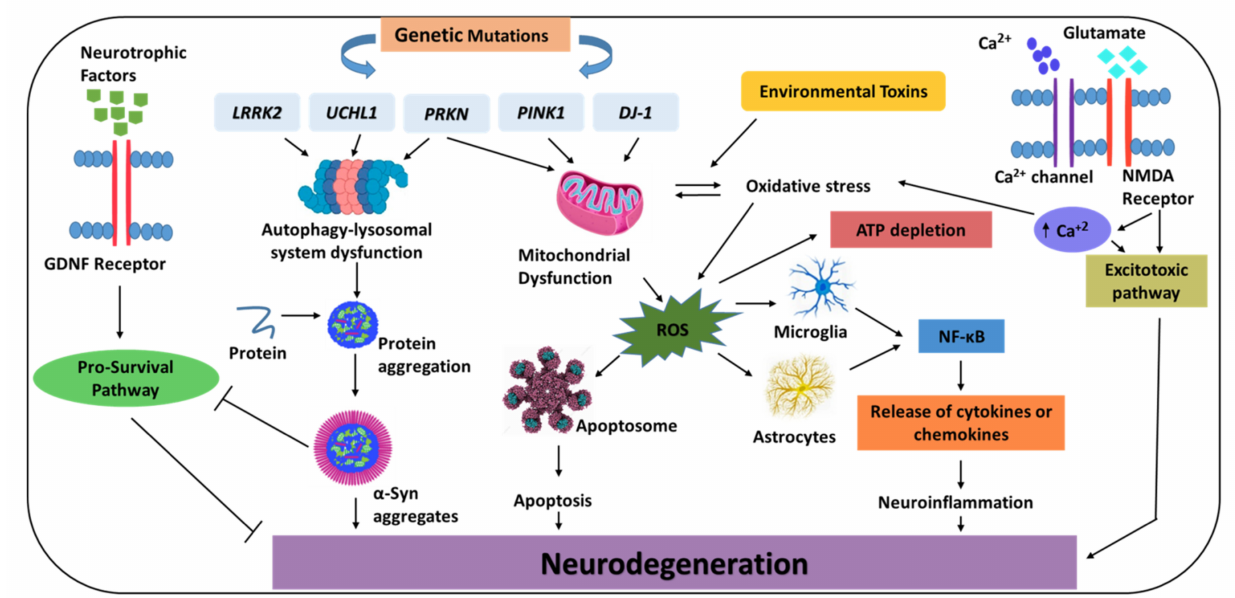
Figure 1. Molecular pathways involved in the pathophysiology of Parkinson’s disease (PD). Common pathogenic mechanisms in PD, including genetic mutation, defective protein clearance, mitochondrial dysfunction, loss of trophic factors, alterations of intracellular Ca 2+ homeostasis, and neuroinflamma- tion, are illustrated. Enhanced signaling pathways are indicated by solid arrows, and suppressed pathways are by blocked arrows. GDNF: glial cell-derived neurotrophic factor, LRRK2 : leucine-rich repeat kinase 2, UCHL1 : ubiquitin C-terminal hydrolase L1, PRKN : parkin, PINK1 : phosphatase and tensin homolog-induced kinase 1, DJ-1 : Daisuke-Junko-1, α -Syn: alpha-synuclein, ROS: reactive oxy- gen species, TNF- α : tumor necrosis factor-alpha, IL-1 β : interleukin-1 β , IL-6: interleukin-6, NMDA: